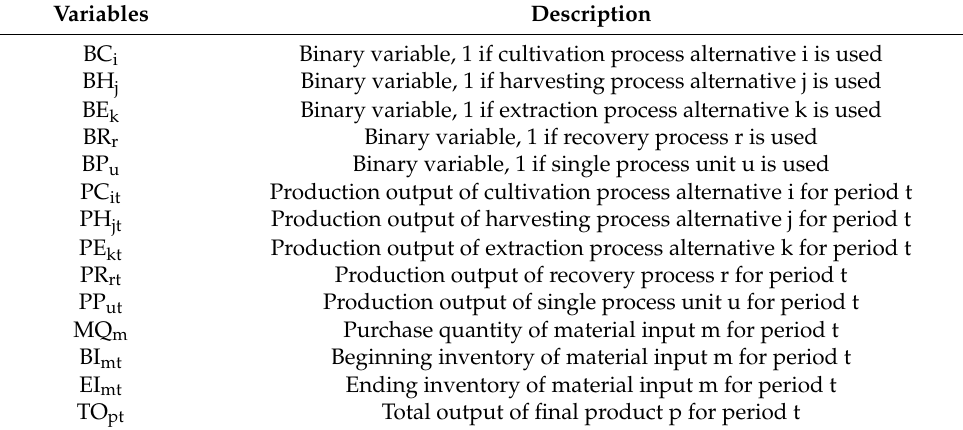
Table A10. Model